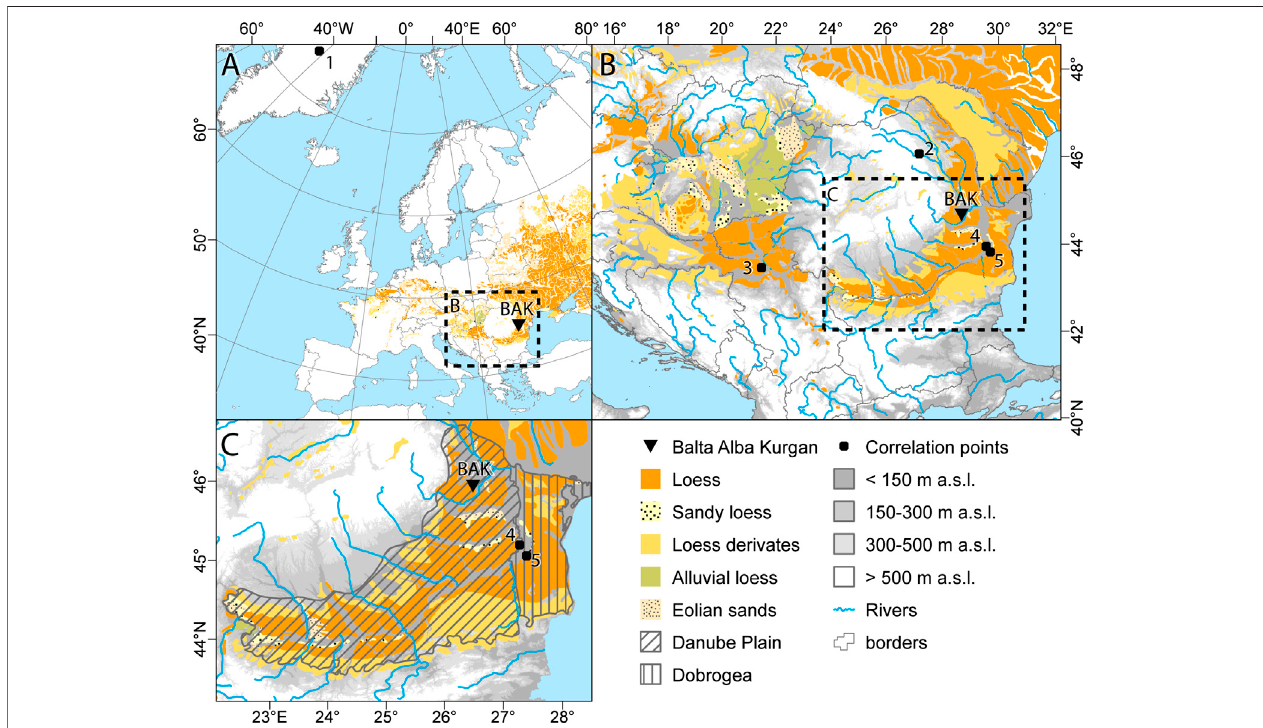
FIGURE 1 | Location ofthe study area and distribution of eolian sediments (according toHaase et al. (2007), modi fi ed). (A) Europe. (B) SoutheastEurope. (C) The Lower Danube Basin with landscape units (according to Jipa (2014), modi fi ed). Black circles indicate the correlation sites for magnetic stratigraphy as described in Magnetic Stratigraphy . 1) NGRIP, 2) Poiana Ciresului, 3) Batajnica, 4) Vlasca, 5) Rasova. Elevation contours (based on JAXA, 2016) are shown to illustrate the natural altitudinal boundaries of loess distributions.